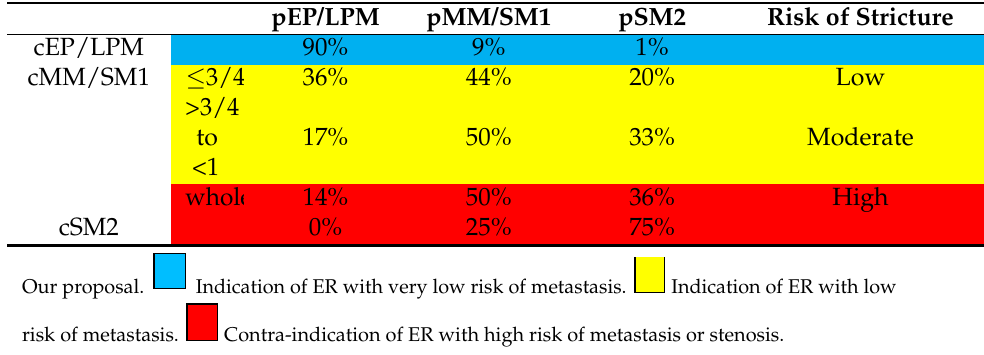
Table 2. The indications for endoscopic resection (ER) according to clinical diagnosis of cancer invasion depth and circumferential spread.